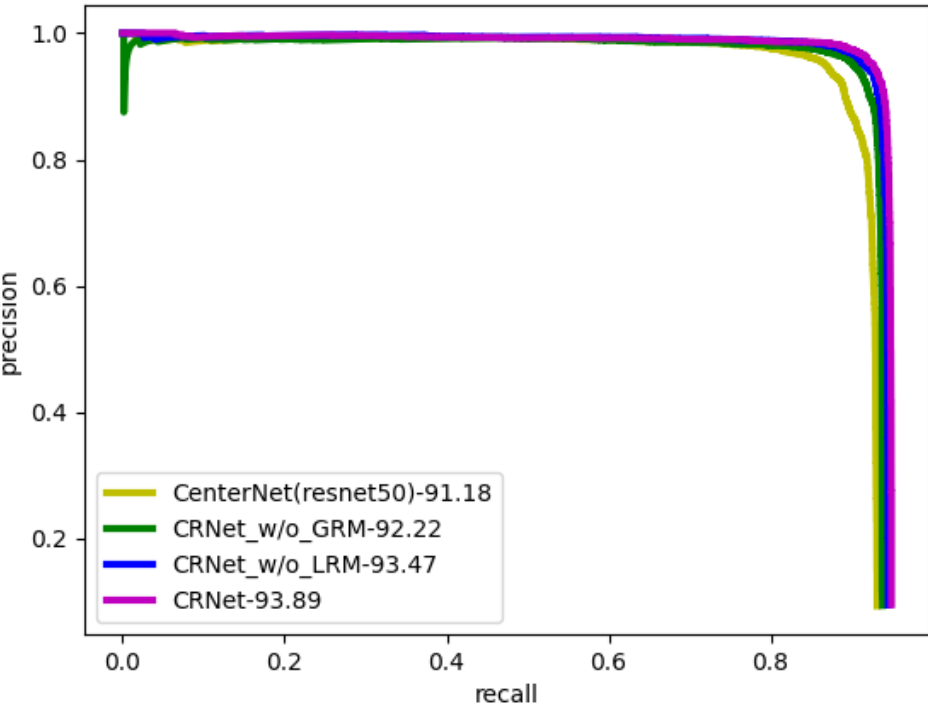
Figure 4. The PR curves of ablation analysis at IoU 0.5 on the Brainwash dataset.